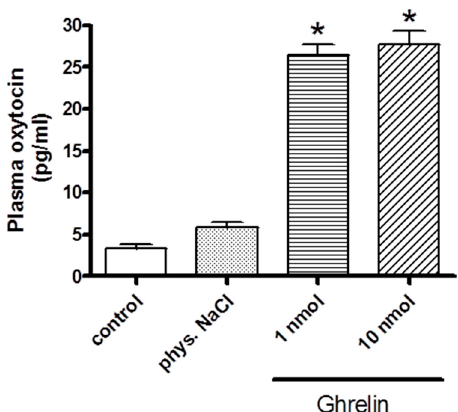
Figure 2. Effects of systemically (i.v.) administered ghrelin on oxytocin secretion (expressed as pg/ml). Results shown as means ± S.E.M., n = 10 . Statistical significance: * p < 0.05 relative to the control group .